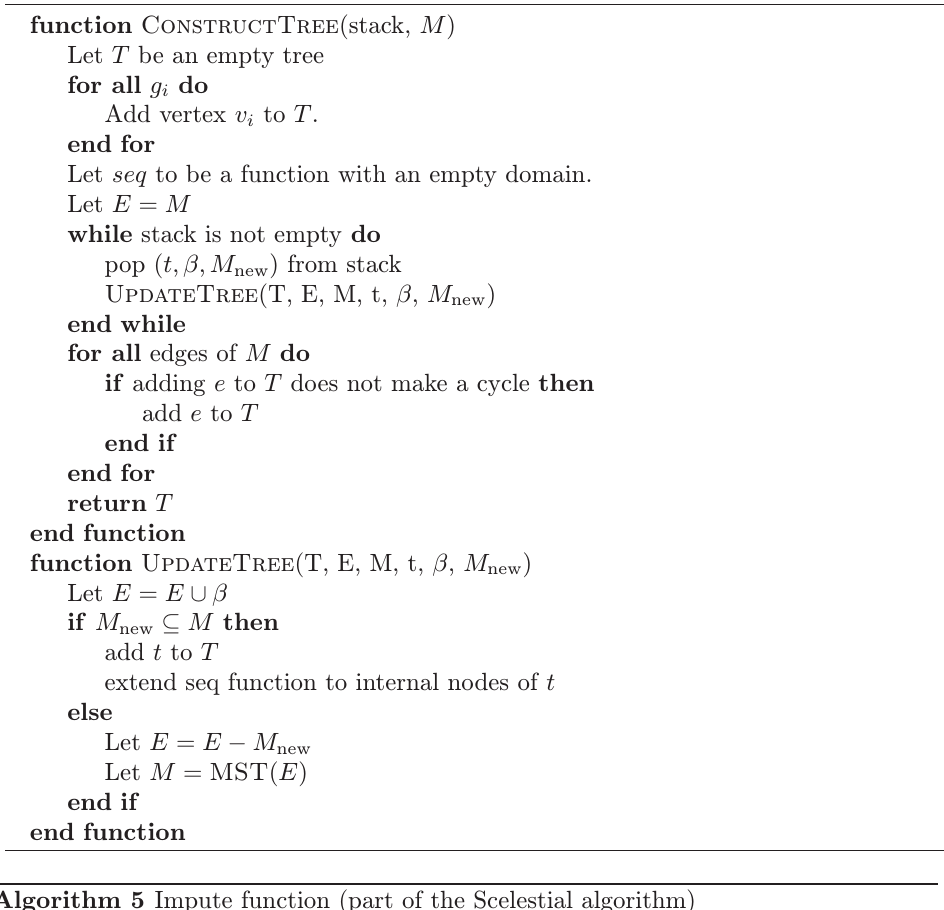
Algorithm 4 ConstructTree function (part of the Scelestial algorithm)